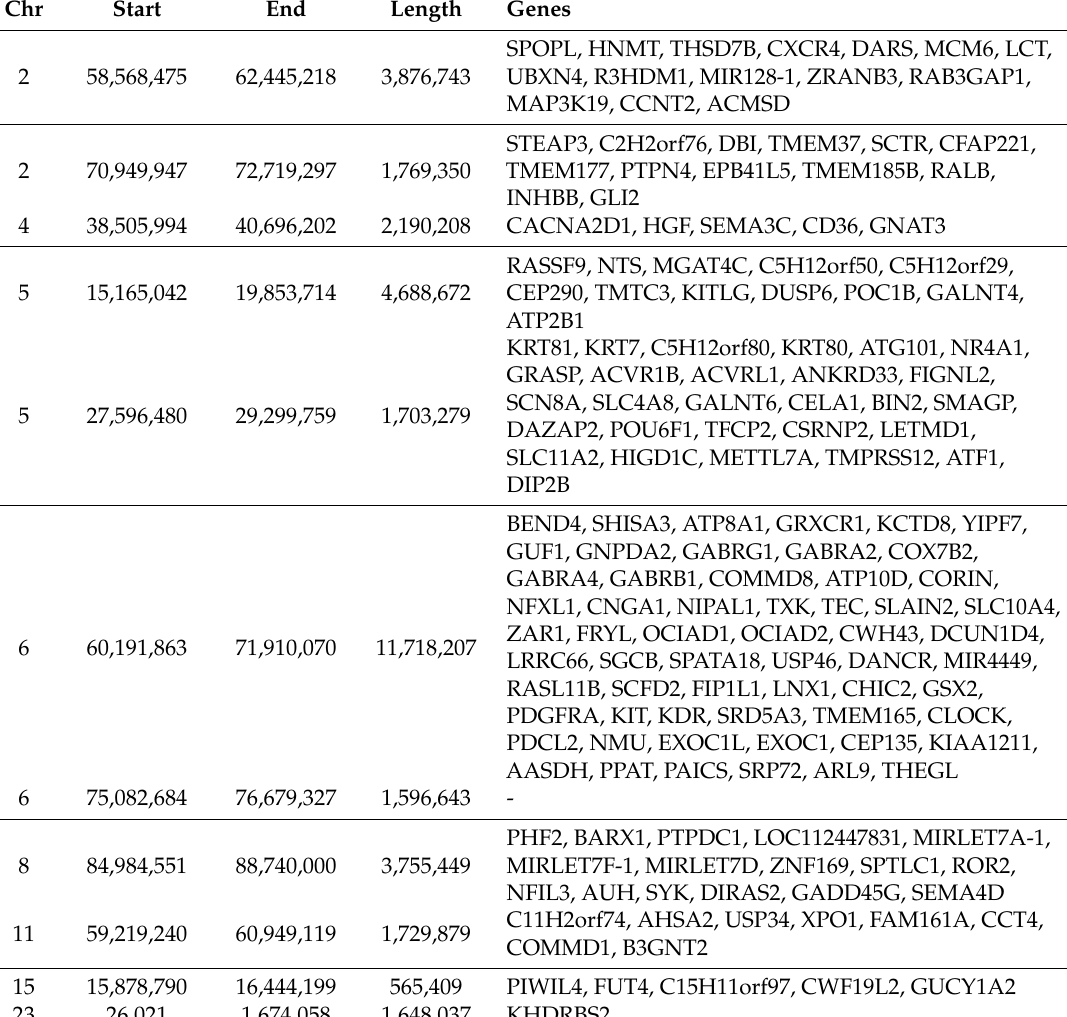
Table 4. VRP TOP_ROH and annotated